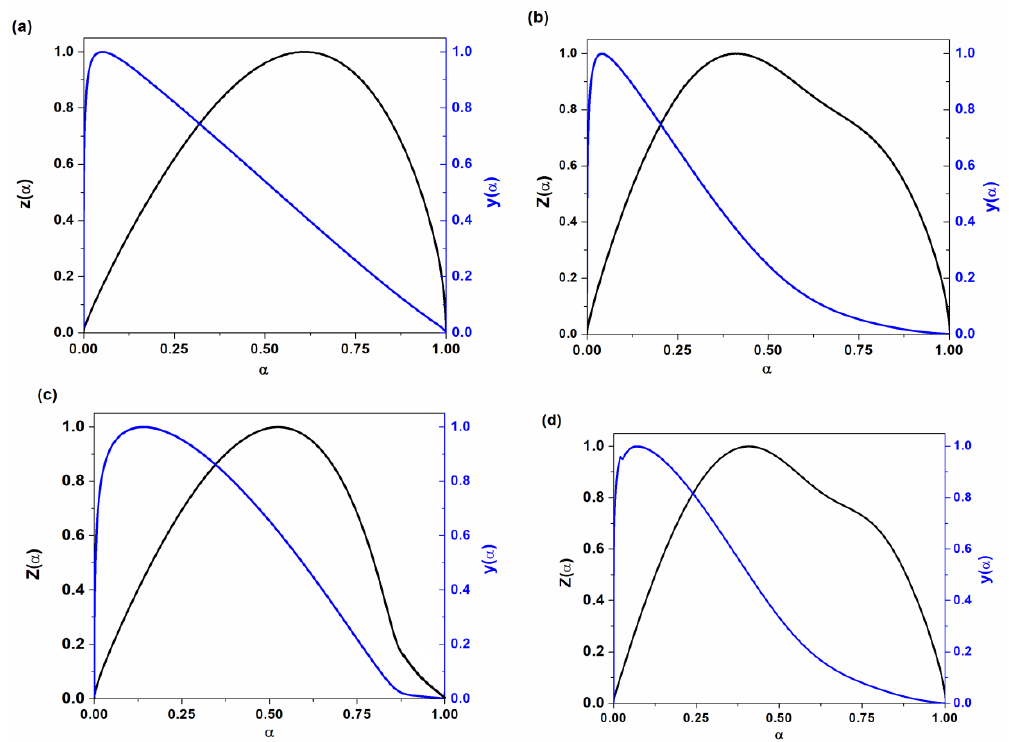
Figure 9. Variation of y(α) and Z(α) versus conversion for ( a ) neat epoxy, ( b ) epoxy/P-HNT, ( c ) ( c ) epoxy / A-HNT and ( d ) epoxy / F-HNT nanocomposites based on Malek model. epoxy/A-HNT and ( d ) epoxy/F-HNT nanocomposites based on Malek model.